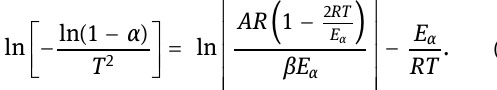
Figure 5: TG – DTG curves of K4 sample at di ff erent heating rates: ( a ) TG and ( b ) DTG curves.